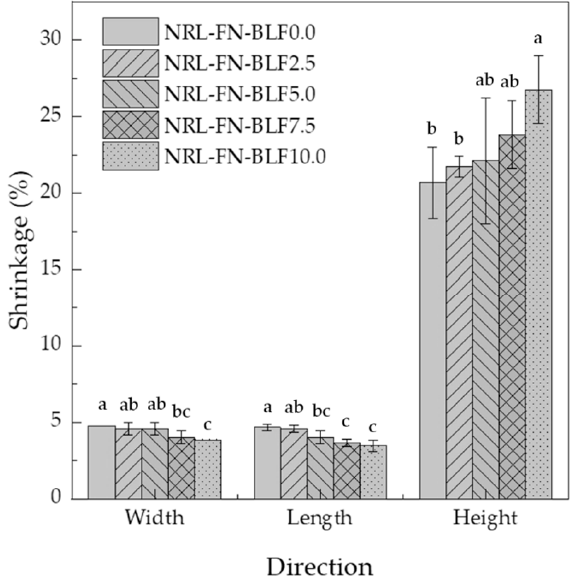
Figure 6. Shrinkage percentage of NRL foam composite at various BLF loading at different shrinkage directions compared with silicone mold size. Significant differences at p < 0.05 are shown by different letters. The values represent the mean ± S.E. of five replicates.